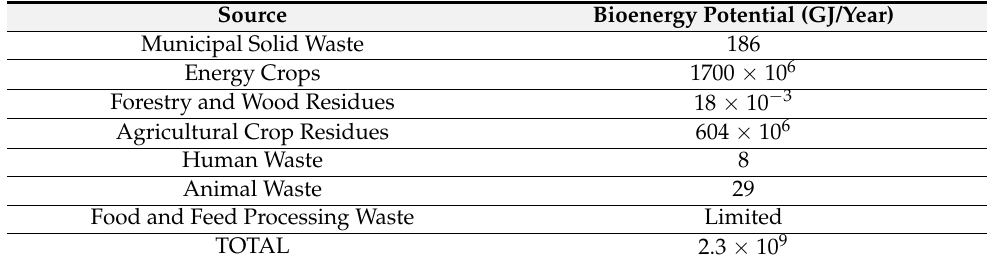
Table 5. Bioenergy potential, Nigeria (2013). Data taken from